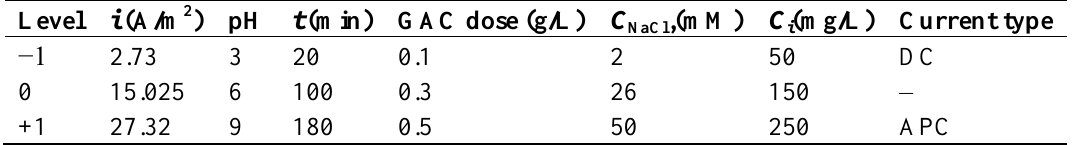
Table 2. Predictor variables and their coded and actual values used in the experimental design. Level